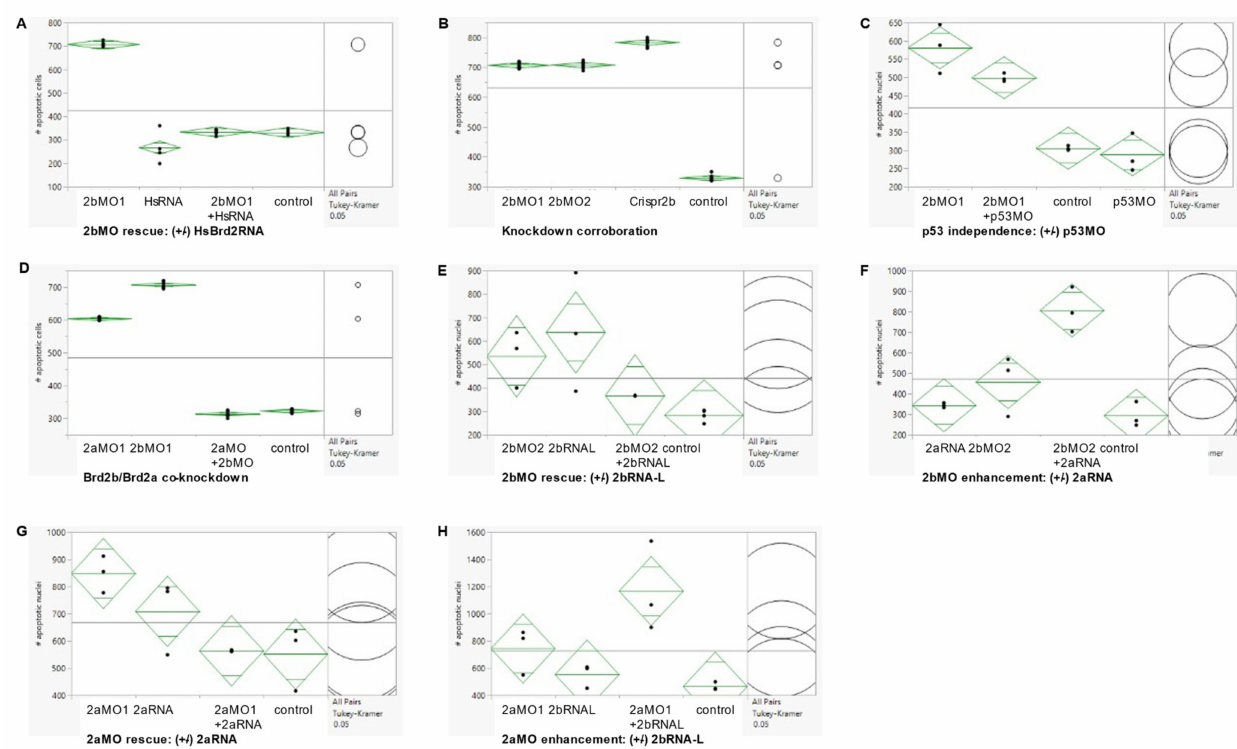
Figure 5. Quantitative TUNEL analysis of cell death: knockdown, co-knockdown, and antagonism studies. Cell death levels were measured in brd2b MO morphants and control embryos under various treatments using fluorescence TUNEL assay followed by quantitative laser-scanning confocal microscopy. The number of apoptotic nuclei in multiple optical sections from the brains of three to ten embryos per treatment, depending on experiment, were compared (see Methods for details). ( A ) RNA rescue treatments: brd2b MO1-injected (2bMO1), human Brd2 RNA-injected (HsRNA), brd2b MO1 + human Brd2 RNA-injected (2bMO+HsRNA), and uninjected (control). Means vary significantly by treatment ( p < 0.0001, one-way ANOVA, Tukey’s HSD), with the greatest difference between 2bMO1 and all other treatments and no significant difference between “control” and “2bMO+HsRNA”, indicating effective rescue by exogenous human Brd2 RNA. Cell death numbers for HsBrd2 RNA-injected controls were obtained from embryos from a separate clutch but reflect what we have consistently seen over multiple independent trials. ( B ) brd2b MO knockdown corroboration treatments: brd2b MO1-injected (2bMO1), brd2b MO2-injected (2bMO2), Crispr-Cas9- brd2b disruption (Crispr2b), and uninjected (control). Means vary significantly by treatment ( p < 0.0001, one-way ANOVA, Tukey HSD), with Crispr2b, 2bMO1 and 2bMO2 all showing effects significantly greater than “control”; 2bMO1 and 2bMO2 show equivalent and moderate effects, while Crispr2b shows the greatest effect. Thus, three independent treatments targeting brd2b result in similarly increased cell death levels, showing gene- specificity of effect. ( C ) p53 -dependent off-target effect treatments: brd2b MO1-injected (2bMO1), brd2b MO1 + p53 MO co-injected (2bMO1 + p53MO), uninjected (control), and p53 MO-injected (p53MO). Means vary significantly by treatment ( p < 0.0001, one-way ANOVA, Tukey’s HSD), with no significant difference between 2bMO1 and “2bMO1 + p53MO” or between “control” and p53MO, but significant differences between the two pairs, indicating excess apoptosis is brd2b - specific, and not the result of p53-dependent off-target effects. ( D ) Co-knockdown treatments: brd2a MO1-injected (2aMO1), brd2b MO1-injected (2bMO1), brd2a MO1 + brd2b MO1 co-injected (2aMO+2bMO), and uninjected (control). Means vary significantly by treatment ( p < 0.0001, one-way ANOVA, Tukey’s HSD), with “control” and “2aMO + 2bMO” not significantly different from each other and both significantly different from either 2bMO1 or 2aMO1; 2bMO1 shows a greater effect than 2aMO1. Simultaneous knockdown of both paralogs suppresses excess cell death observed in single knockdowns of either paralog and restores wild type levels of apoptosis. Panels ( E – H ): Rescue-Enhancement studies using zebrafish brd2a and brd2b-L in vitro-synthesized RNAs (not human Brd2 ) tested functional antagonism between paralogs at the level of apoptosis. ( E ) brd2b MO rescue treatments: brd2b MO2 (2bMO2), brd2b - L RNA (2bRNAL), brd2bMO2 + brd2b-L RNA (2bMO2 + 2bRNAL), and uninjected (control). Means vary significantly by treatment ( p -0.0286, one-way ANOVA, Tukey’s HSD), with “2bMO2+2bRNAL” closer to “control” in effect ( p = 0.8407) than either 2bMO1 ( p = 0.1319) or 2bRNAL ( p = 0.0295), indicating partial rescue of the brd2b MO morphant